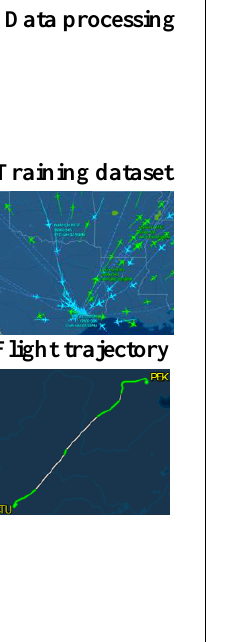
Figure 1. The framework of the proposed trajectory prediction approach. DPG: deep Gaussian process (DGP); NFT: nominal flight trajectory (NFT); CI: confidence interval (CI).